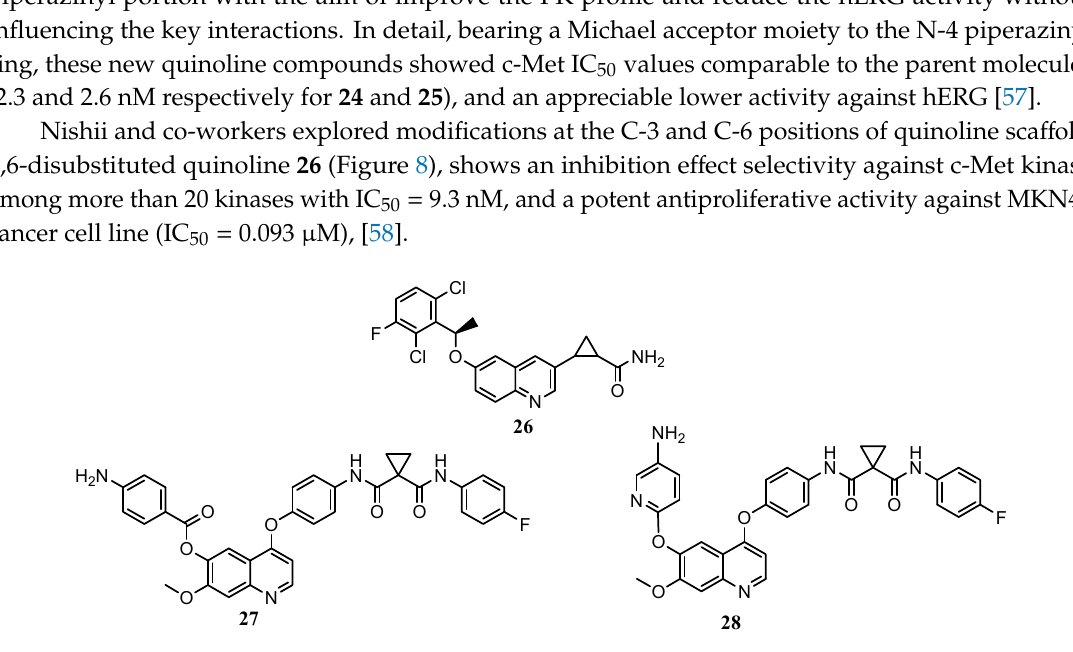
Figure 8. 4,6,7-substitued quinoline derivatives selectively active on c-Met [58,59].